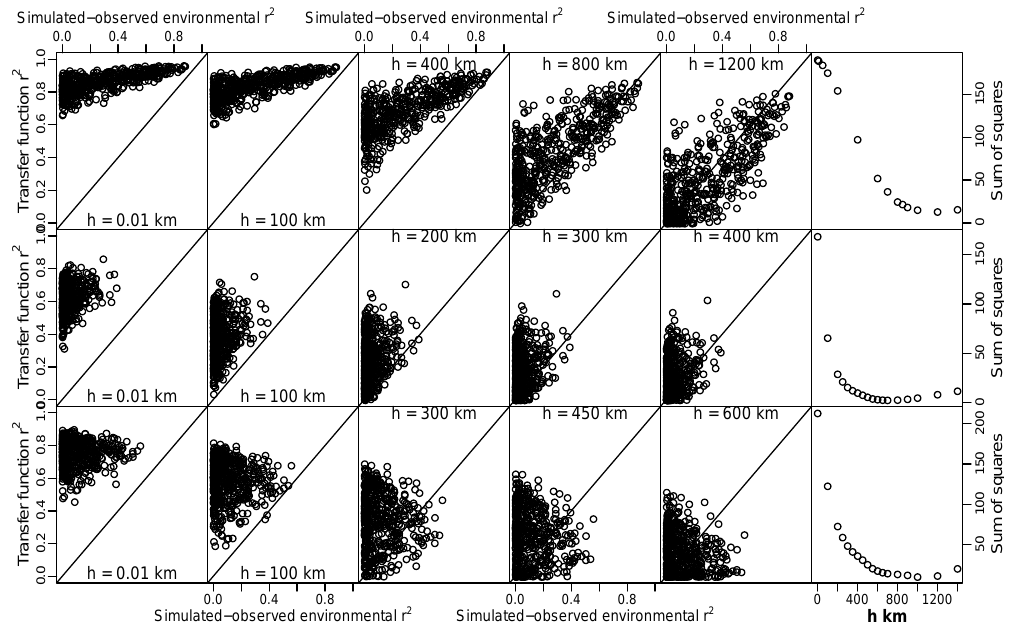
Figure 5. Results of the variance-explained method. First row: planktonic foraminifera winter sea-surface temperature transfer function; second row: Arctic pollen July temperature transfer function; third row: Arctic pollen July sunshine transfer function. The first five columns show the relationship between transfer-function r 2 and the r 2 between simulated and observed environmental variables. Transfer-function r 2 changes as a function of h (indicated in the panel). The last column shows the sum of squares between transfer-function r 2 and simulated and observed r 2 as a function of h